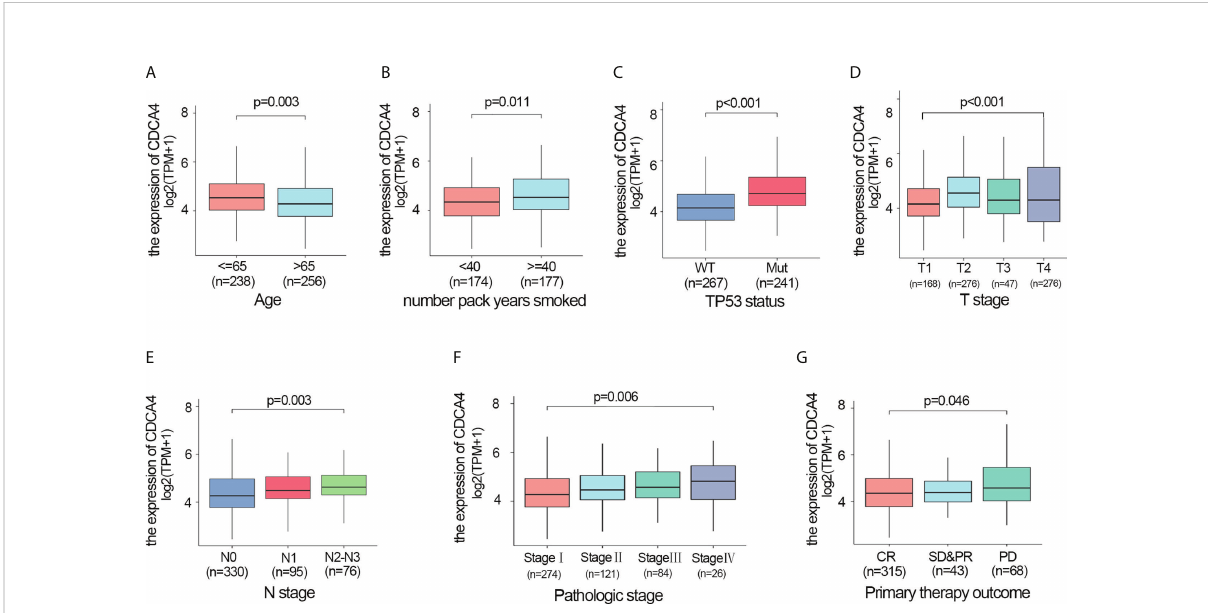
FIGURE 2 Higher CDCA4 expression was associated with unfavourable clinicopathological characteristics in LUAD. (A – G) CDCA4 expression was strongly correlated with younger age, more years of smoking, patients ’ T-stage, N-stage, pathological stage, poor primary therapy outcome and more P53 mutation ( P